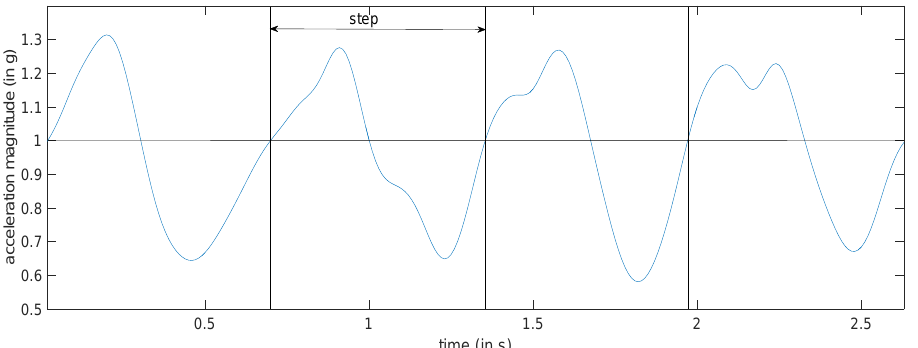
Figure 3. Example of the measured acceleration magnitude | a | with the boundaries for each